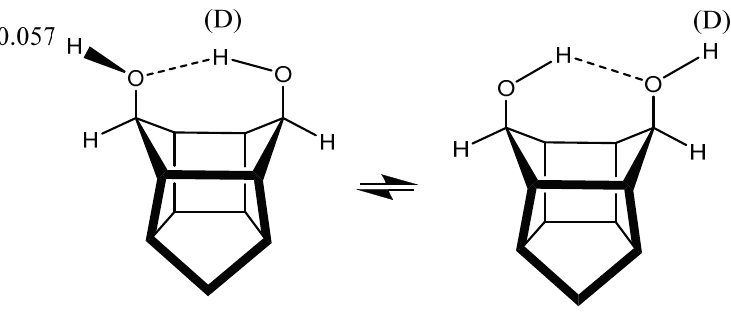
Figure 21. Deuterium isotope effects on 1 H chemical shifts in cage